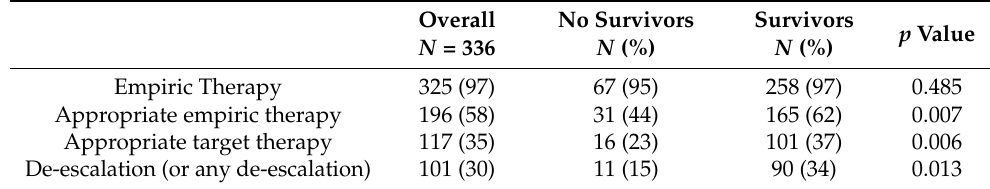
Table 2. Univariate analysis of mortality according to appropriate treatment and de-escalation rates.